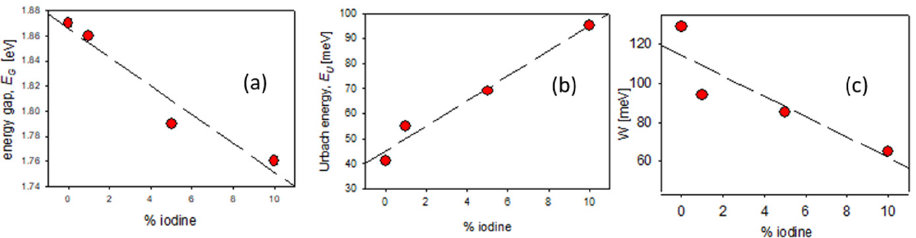
Figure 3. Optical parameters of neat and iodine-doped P3HT films ( a ) energy gap ( b ) the Urbach energy ( c ) the exciton bandwidth, as a function of % mol. content of iodine.